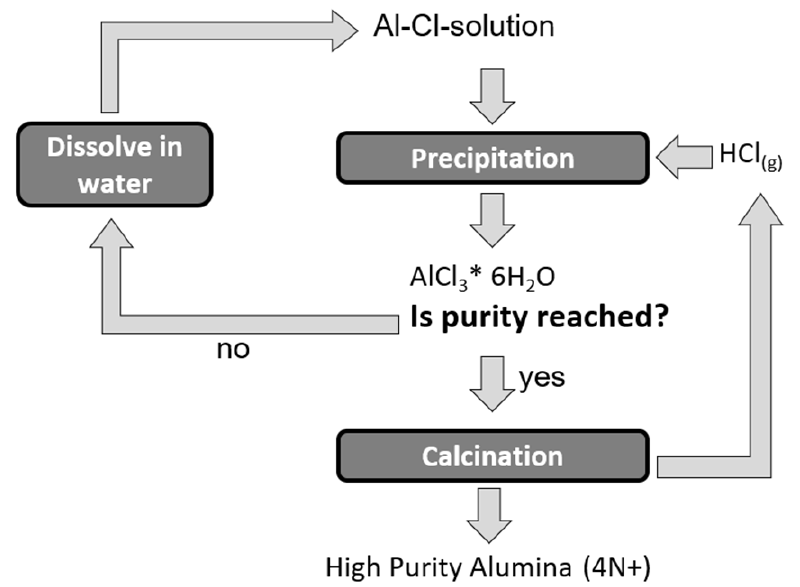
Figure 1. Process flow of ACH purification.